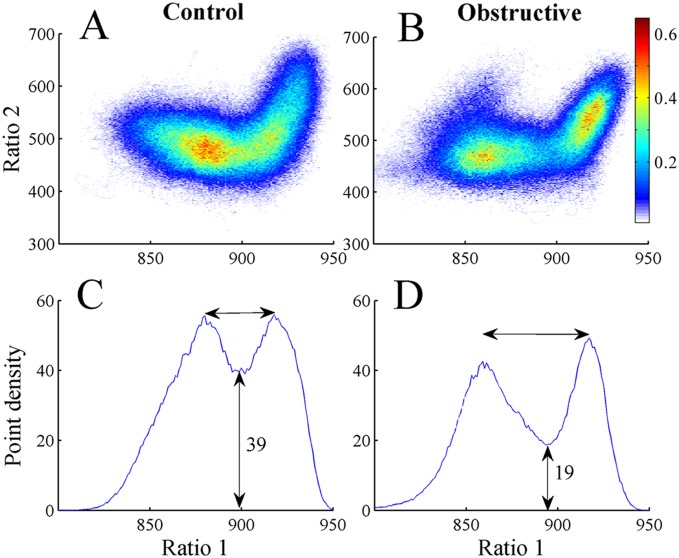
Point densities averaged across all control (A) and UAO (B) animals.Warm colors indicate regions where the average density is high and cool colors indicate low density. (C), (D)–average state space densities for control and UAO rats projected into ratio 1. This projection yields two peaks; left peak is associated with wake and the right peak is associated with SWS sleep.